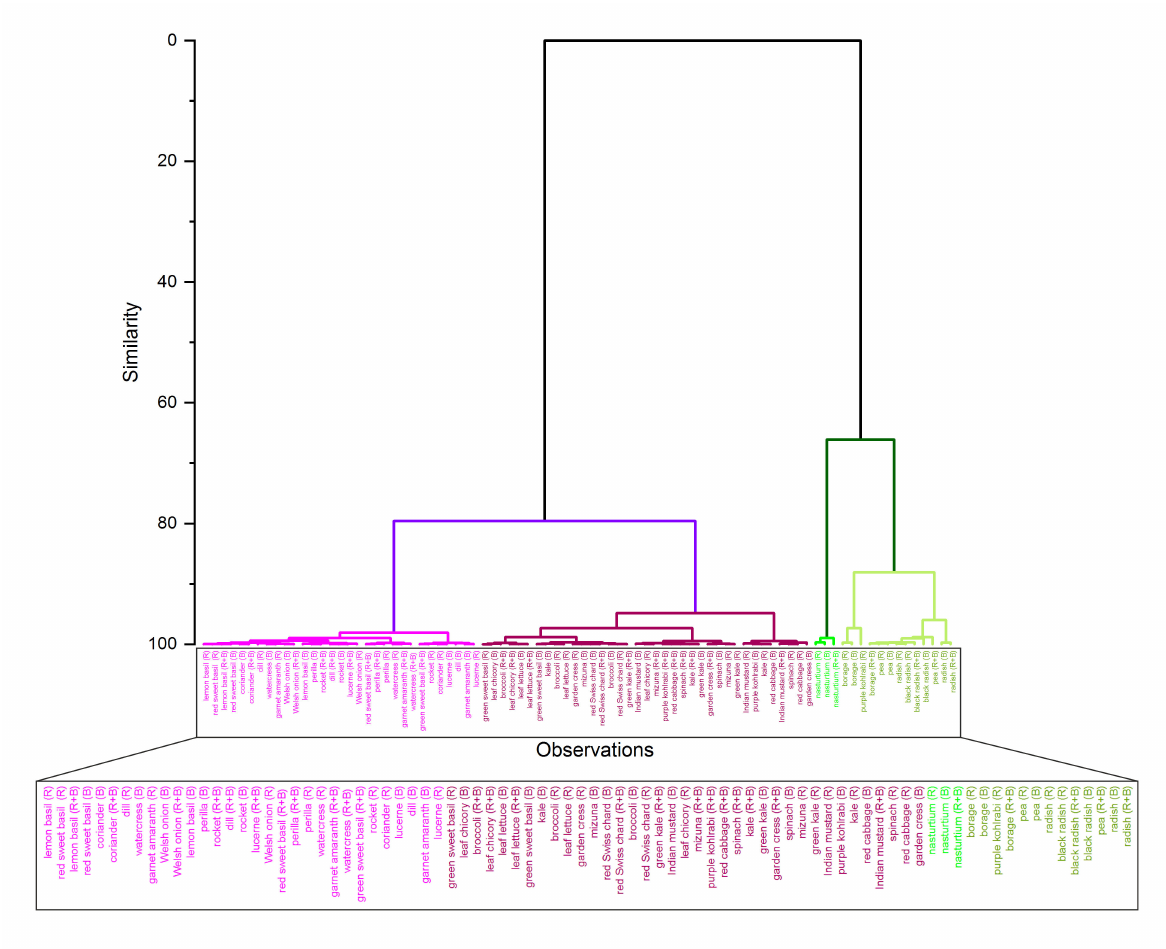
Figure 6. Hierarchical clustering demonstrates biometric parameters of microgreens in relation to the spectral composition of